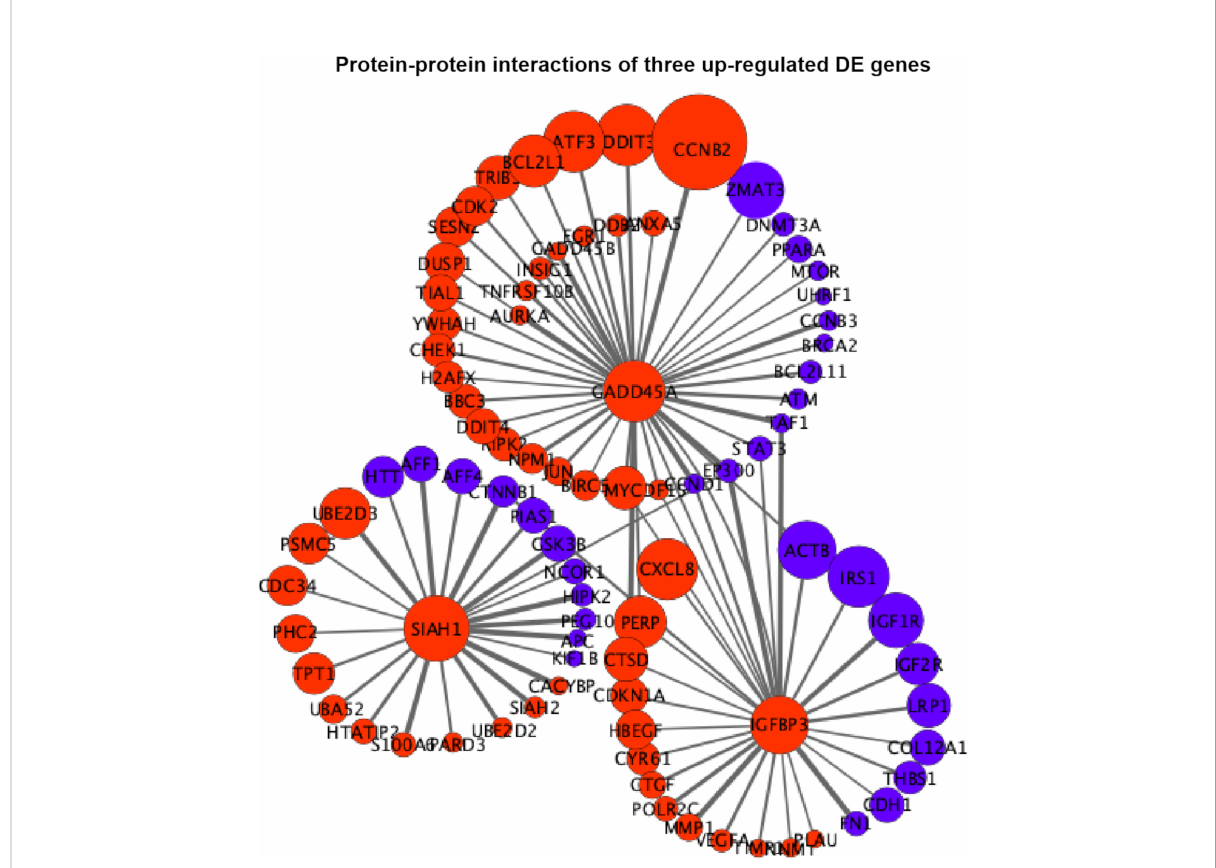
FIGURE 6 Protein – protein interaction (PPI) networks of three extremely upregulated differentially expressed (DE) genes (G ADD45A , IGFBP3 , and SIAH1 ). The circles indicate the nodes (genes) with the edges that are solid lines indicating the interaction scores of PPIs. The sizes of circles indicate the values of |log 2 (FC)|, while the red and blue colors indicate the upregulated and downregulated statuses,